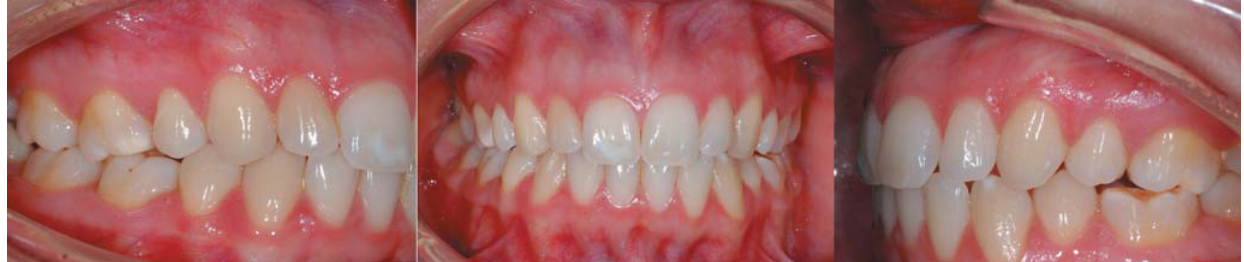
FIGURE 8- Frontal and lateral views 8 years after